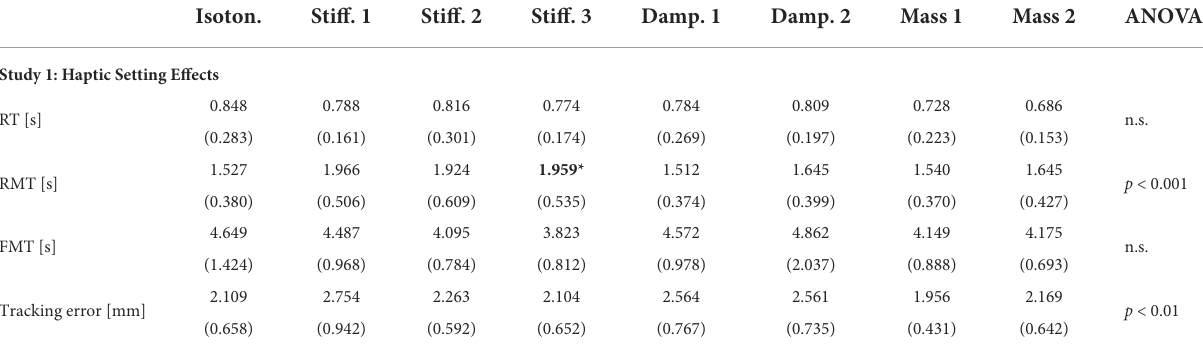
TABLE 3 Effects of haptic settings on performance measures: Means, SD (in parentheses), and rmANOVA main effects.